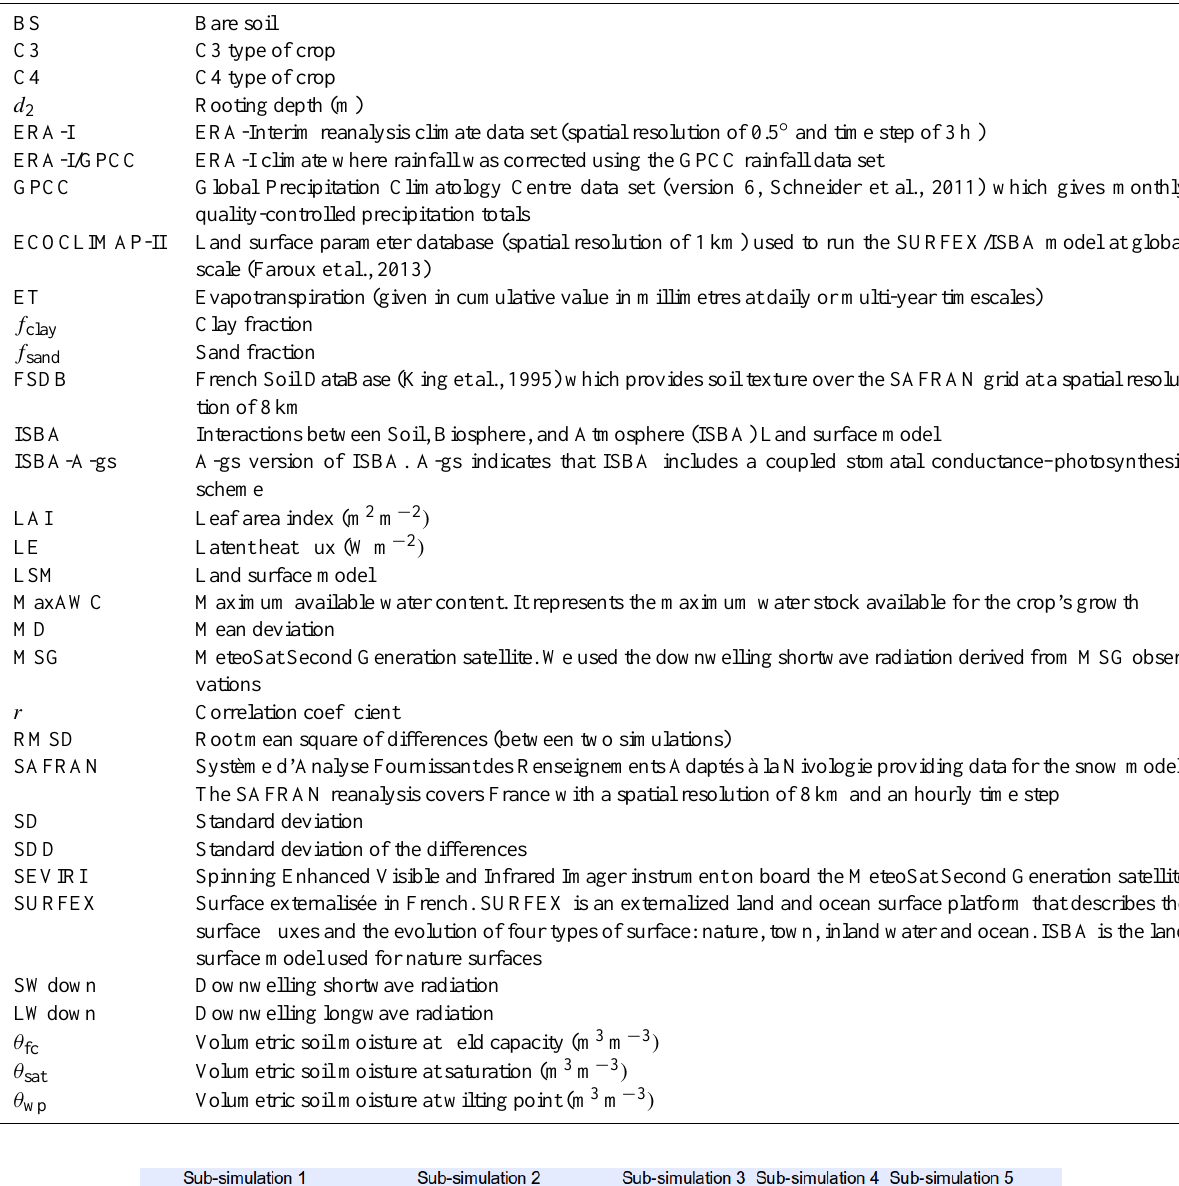
Table 1. Definition of symbols and acronyms.